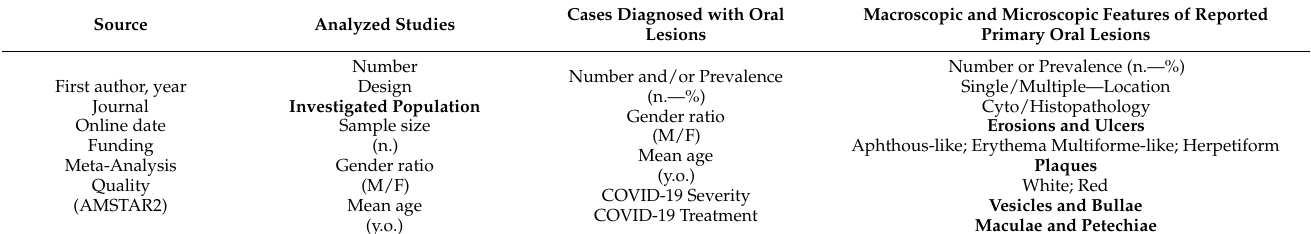
Table 1. Data recorded or computed by reported findings based on eligibility criteria: first author, year, journal and online publication date, funding and quality of systematic the reviews included in the present study and listed in alphabetical order; number and design of analyzed studies, sample size, gender ratio and mean age of investigated population; total number or prevalence of cases diagnosed, through clinical exam, with oral lesions among the investigated population; COVID- 19 illness severity, classified as mild/moderate or severe/hospitalization and ongoing COVID-19 treatment; macroscopic and microscopic features and related frequency of reported oral